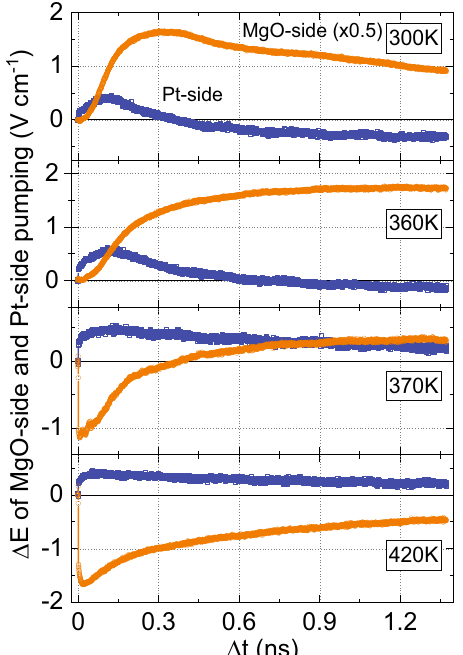
Fig. 4 MgO-side and Pt-side pumped THz emission. Dynamics of the double-pump THz emission Δ E, at μ H ¼ 120 mT for the cases when the 0 MgO/FeRh/Pt heterostructure is pumped from the MgO-side (orange) or the Pt-side